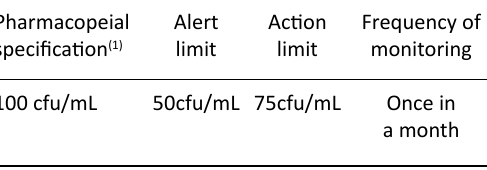
Table 1. Limits and Frequency of Monitoring Pharmacopeial